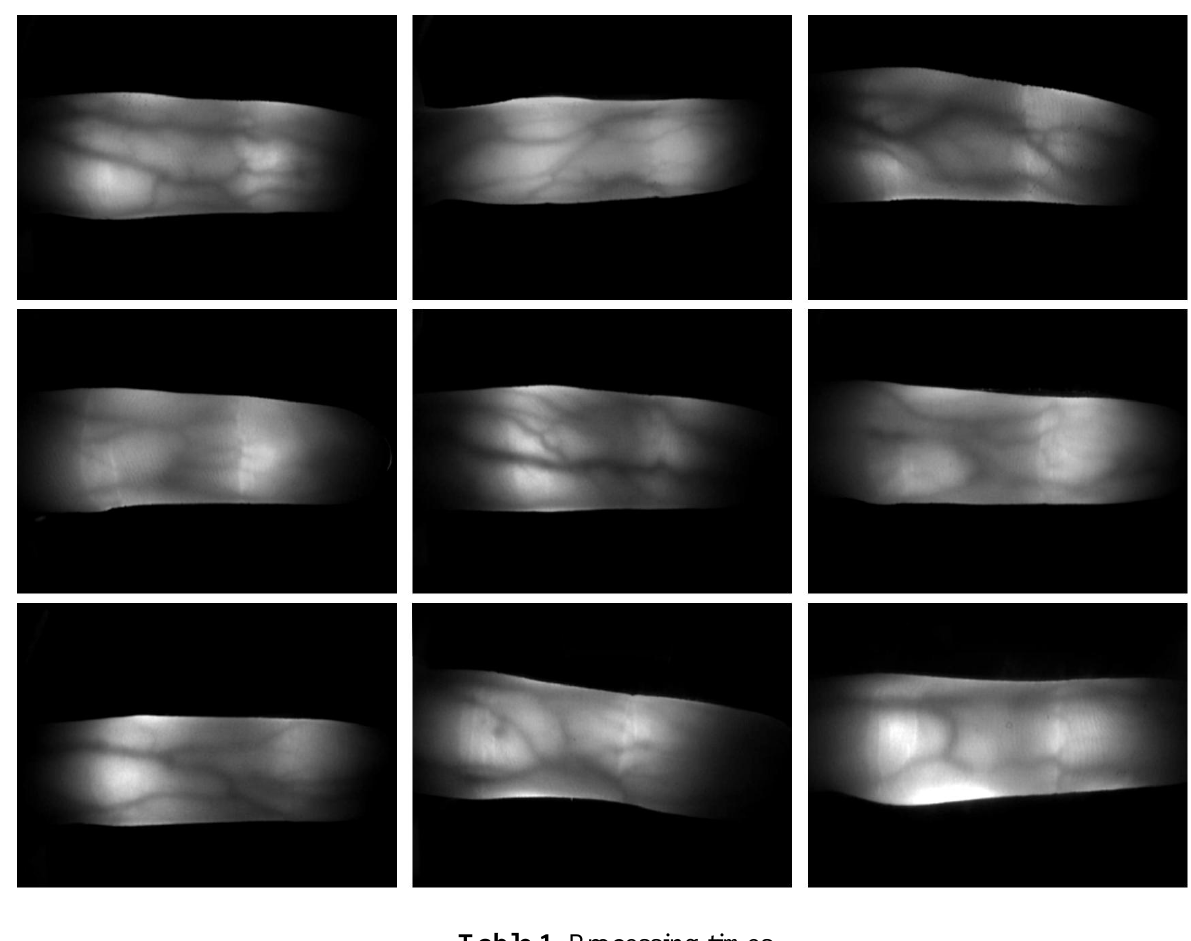
Figure 9. Examples of IR finger